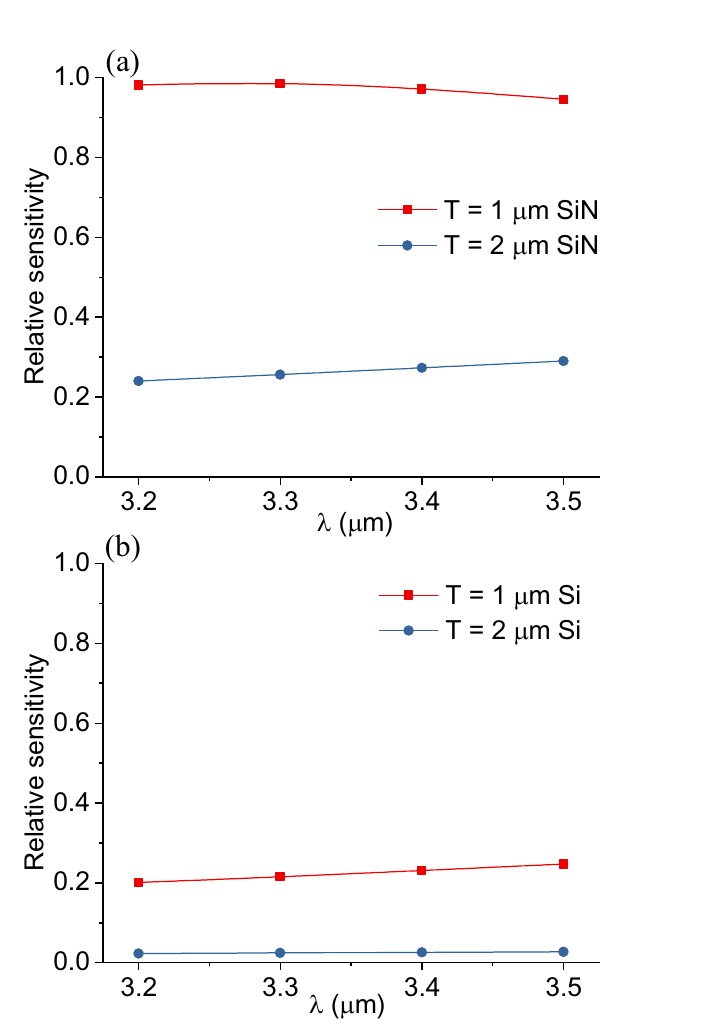
Figure 6. Sensitivity vs wavelength (λ) for ( a ) SiN and ( b ) Si waveguides at thicknesses T = 1 and 2 μm,